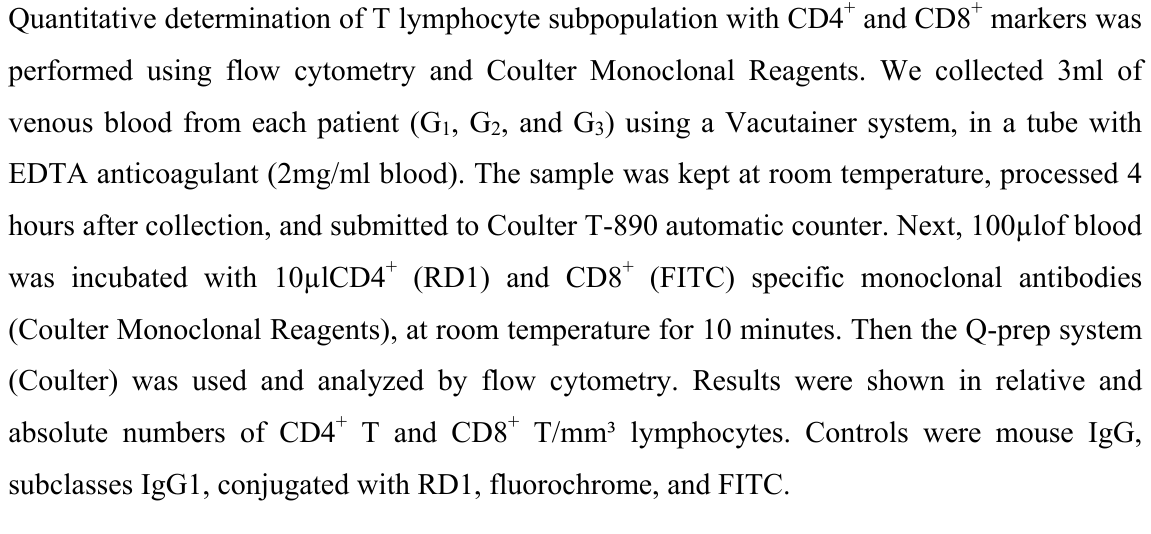
D. A. Meira et al . CORRELATION BETWEEN CYTOKINE SERUM LEVELS, NUMBER OF CD4 + T CELLS/mm³ AND VIRAL LOAD IN HIV-1 INFECTED INDIVIDUALS WITH OR WITHOUT ANTIRETROVIRAL THERAPY.